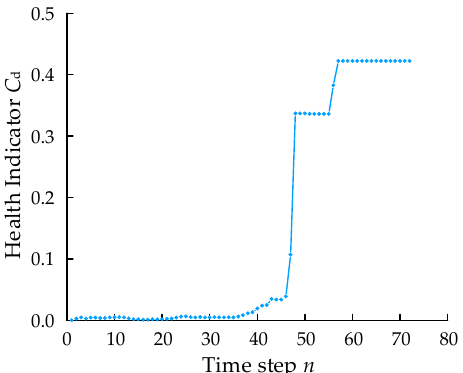
Figure 7. Regularity of health status indicators over time (total time step n = 73).